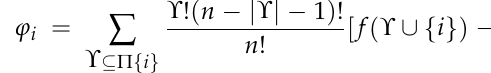
p F η T Figure 6. Confusion matrix plot.